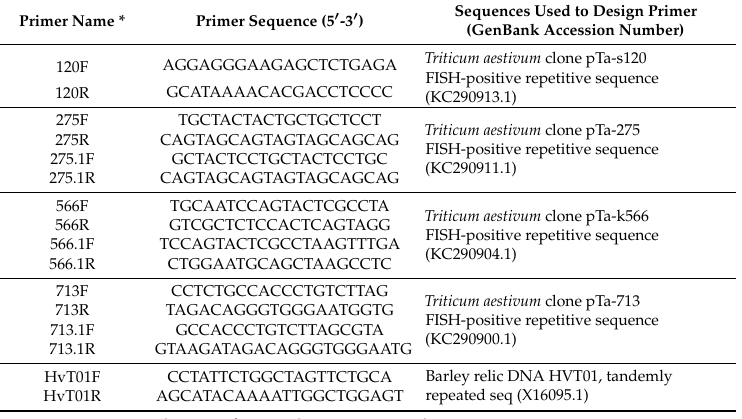
Table 2. Primer pairs that were designed according to original repetitive